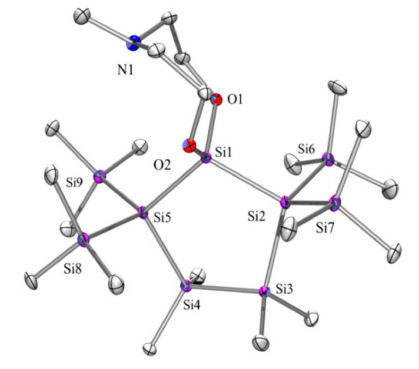
Figure 4. Molecular structure of 9 (thermal ellipsoid plot drawn at the 30% probability level). All hydrogen atoms are omitted for clarity (bond lengths in Å, angles in deg). Si(1)-O(1) 1.656(2),